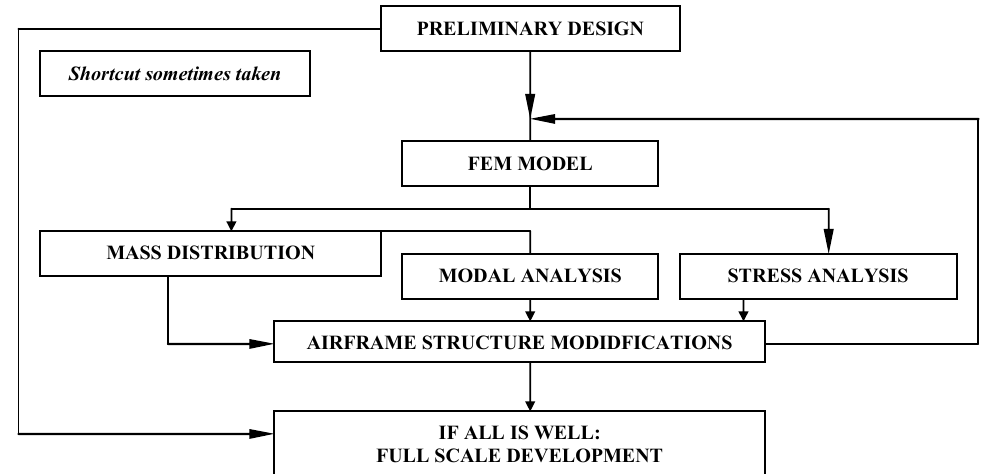
Fig 1. Algorithm of numerically supported preliminary